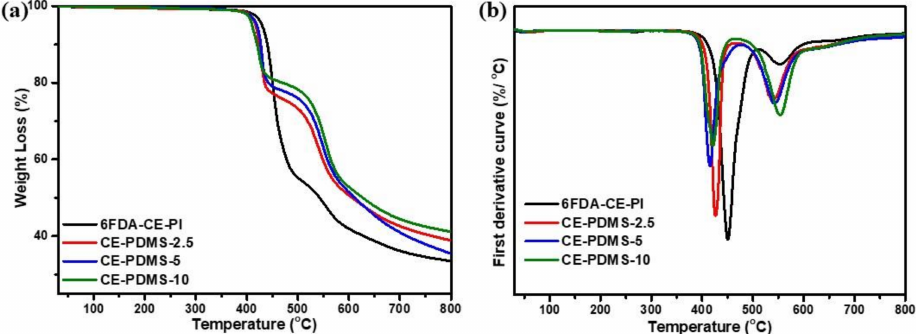
Figure 2. ( a ) TGA curves, ( b ) first-order derivative curves of the low PDMS membranes at 30–800 ◦ C.